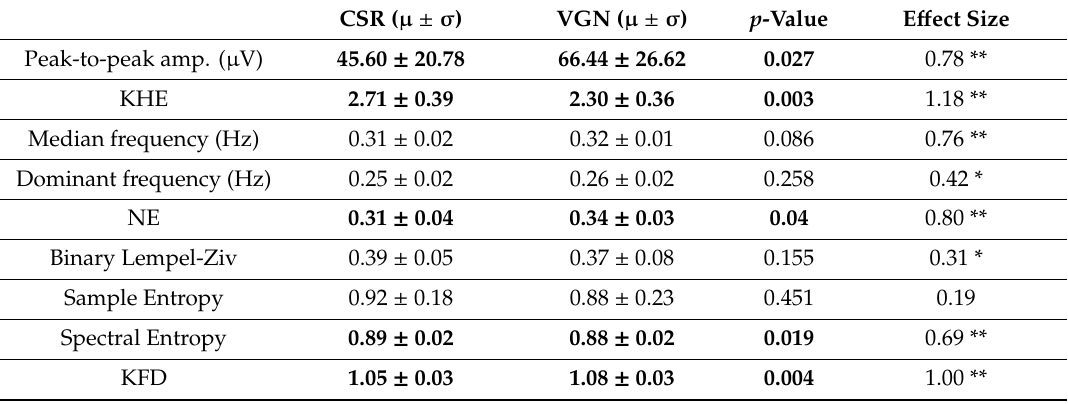
Table 2. Mean and standard deviation values of the electrohysterography characteristics of VGN and CSR groups. Values in bold indicate the statistical di ff erence between groups ( α = 0.05). E ff ect size values are marked with (**) if large and with (*) if medium. KHE: Kurtosis of the Hilbert Envelope; KFD: Katz Fractal Dimension. CSR ( µ ± σ ) VGN ( µ ± σ ) p -Value E ff ect Size Peak-to-peak amp. ( µ V) 45.60 ± 20.78 66.44 ± 26.62 KHE 2.71 ±